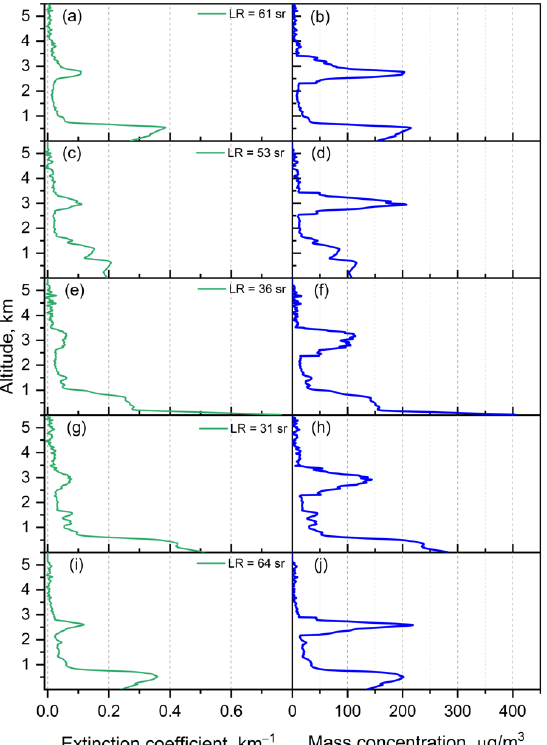
Figure 10. (Left) Aerosol extinction coefficient profiles and LR at 532 nm and (right) mass concentra- tions profiles for different times along the mobile transect: 08:55 ( a , b ); 10:50 ( c , d ); 12:30 ( e , f ); 13:00 ( g , h ); and 15:20 ( i , j ), local time. The extinction profiles were derived using the in situ constraint corrected for the RH.